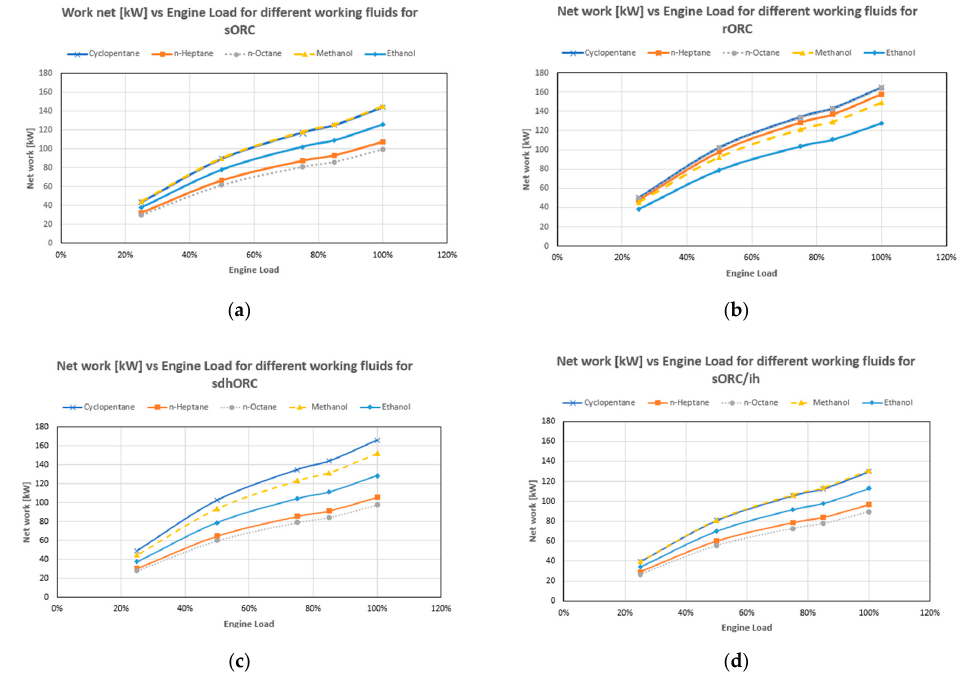
Figure 4. Net Work against Engine Load for different working fluids ( a ) sORC; ( b ) rORC; ( c ) sdhORC; ( d ) sORC/ih.